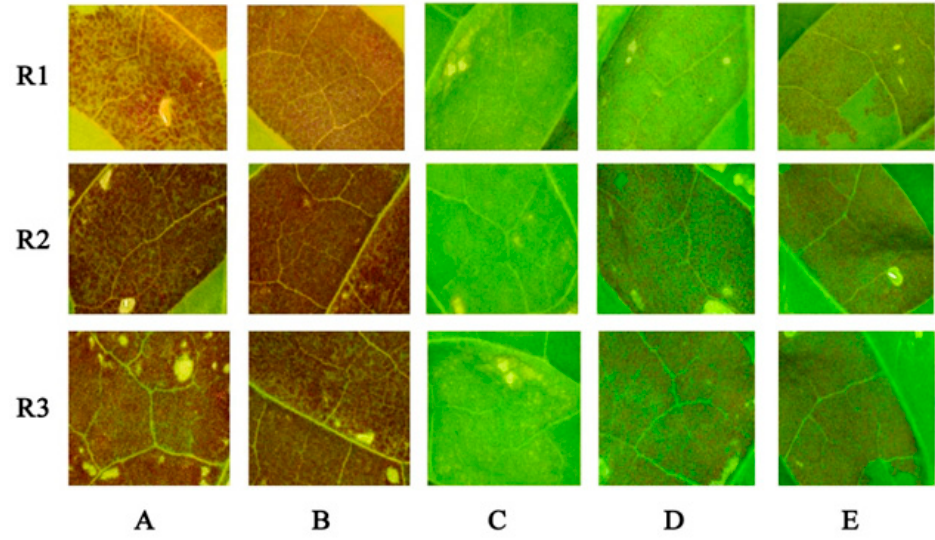
Figure 3. Transient transformation of tobacco leaves ( Nicotiana tabacum ). R1, R2, and R3 represent three replicates. ( A ) Infiltration with StMYB-AN1 ; ( B ) Co-infiltration of pSAK277 with StMYB-AN1 ; ( C ) Infiltration with NtMYB3 ; ( D ) Co-infiltration of StMYB-AN1 with NtMYB3 ; ( E ) Co-infiltration of StMYB-AN1 , NtMYB3 , and StbHLH . Photos were taken after five days of agro-infiltration injection. (Scale bar = 1cm)